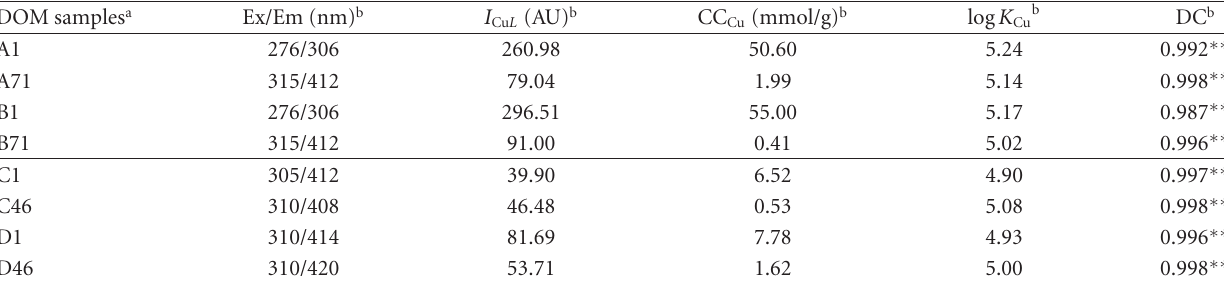
Figure 1: Changes of dissolved organic matter (DOM) concentrations during manure composting. Table 1: Fitting parameters of Ryan-Weber